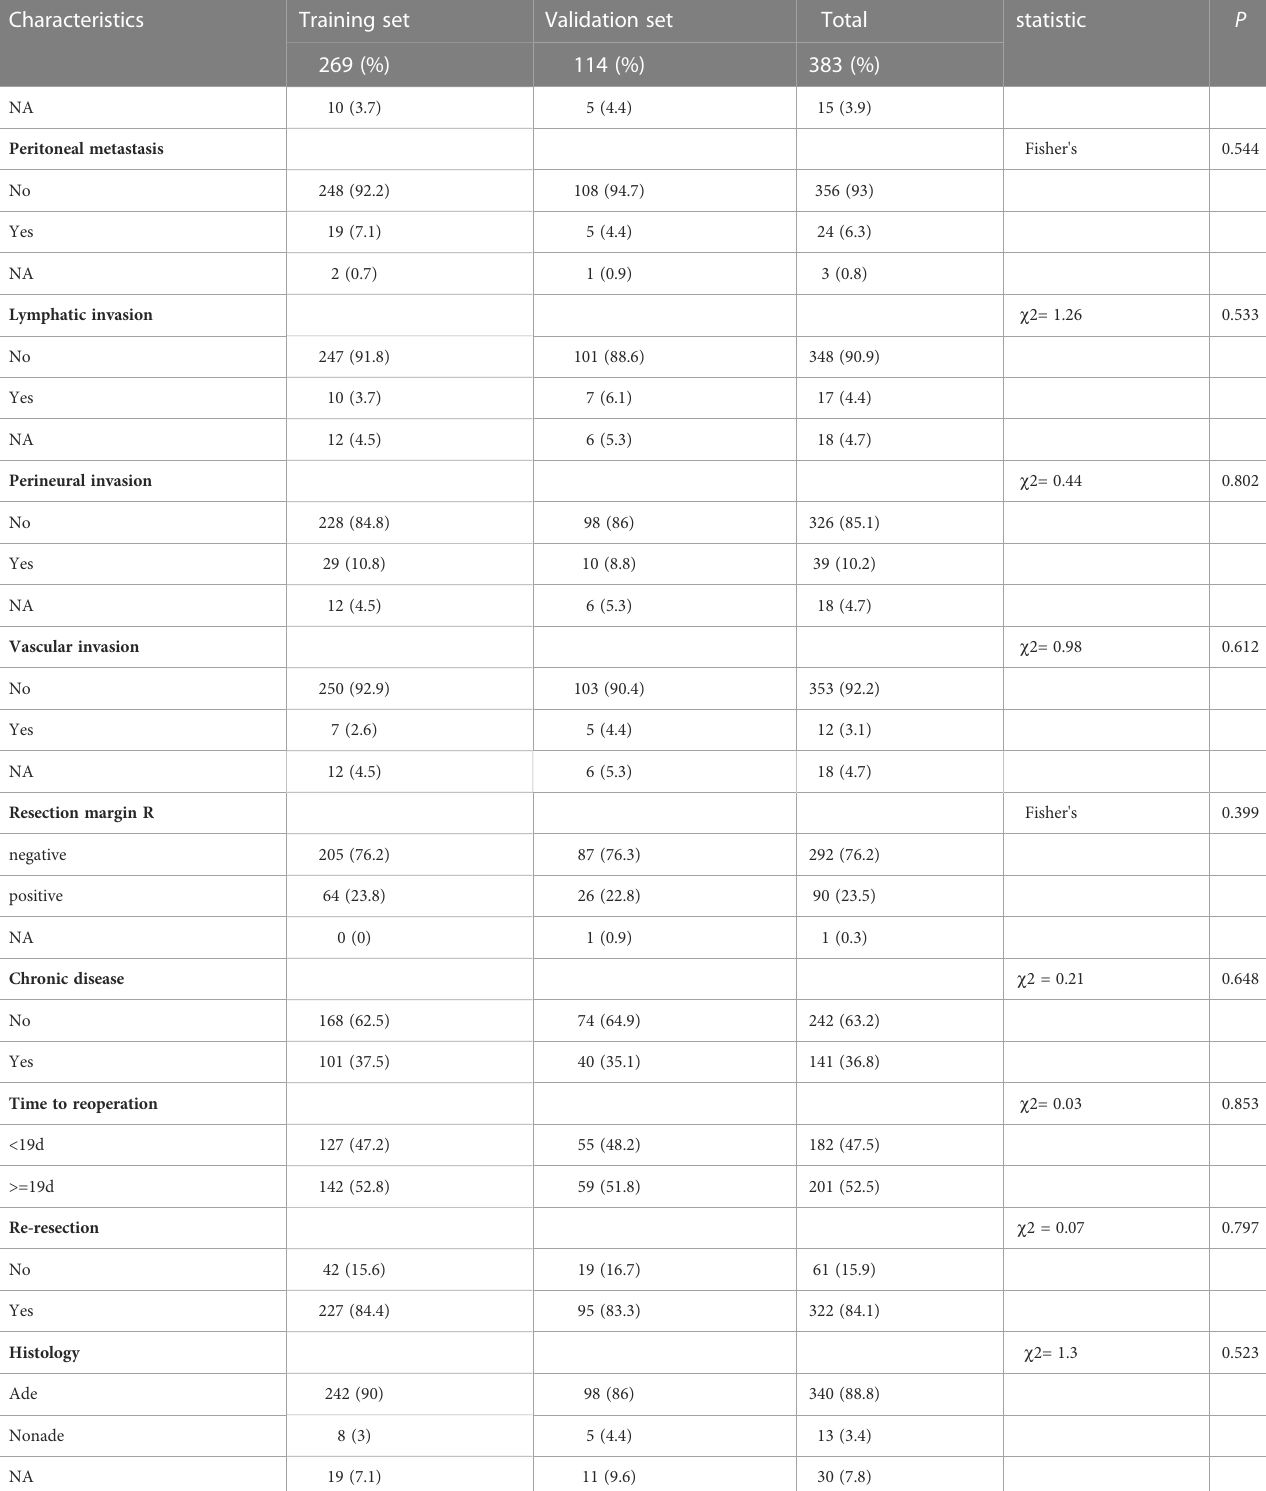
NA, not available; N metastasis, lymph node metastasis; M metastasis, distant metastasis; Ade, adenocarcinoma; Nonade,